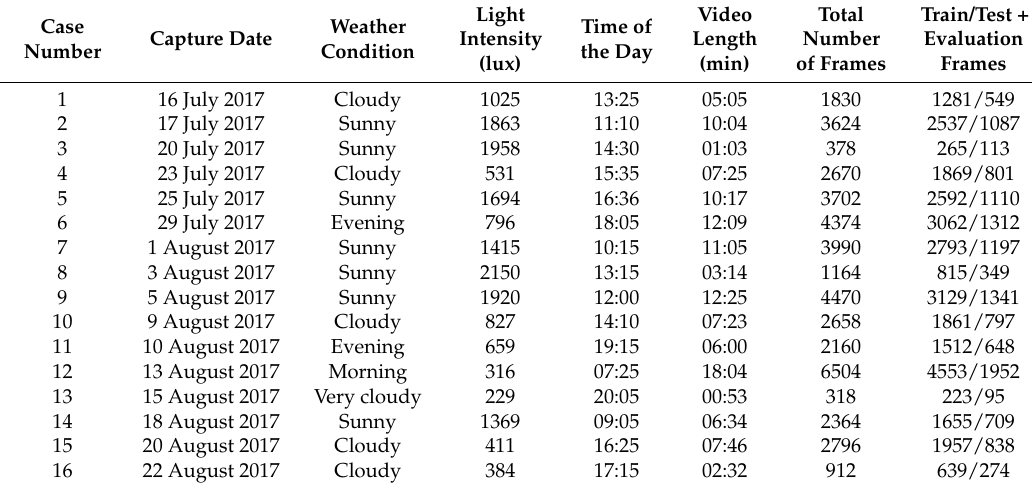
Table 1. Characteristics of the videos captured under 16 different light conditions. The videos were obtained on different days. In the videos of evening and morning, the sky was